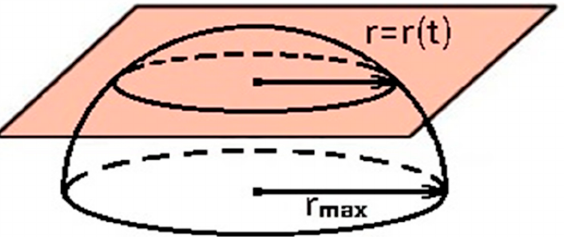
Figure 5. Change in the distribution zone of a substance with a threshold concentration over time .